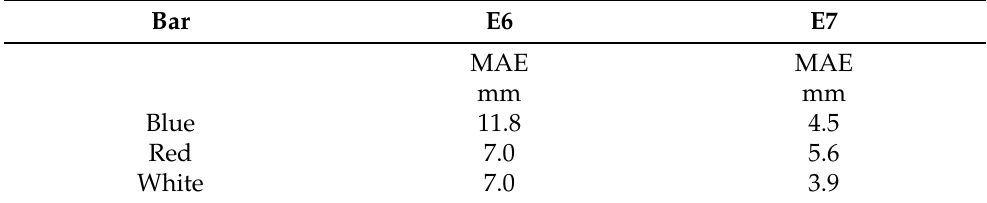
NIR T5 T6 Number of segmentation classesLuminance Red Ch. Green Ch. Blue Ch. Figure 5. Mean absolute error (MAE) in mm between unfiltered and a priori known bar lengths for all experimental tests (E6, left , and E7, right ) treated with the narrow image crop. From top to bottom , heatmaps show MAE values estimated from images of the blue ( top ), red ( middle ), and white ( bottom ) bars. In each heatmap, rows indicate MAEs obtained for different color channels: the top four rows report values for RGB images processed through four gray-scale conversion modalities (luminance, red, green, and blue channels). The bottom row refers to values for NIR images. Values are reported for all segmentation classes (T1 to T6). Table 7. MAE in mm between benchmark and filtered lengths estimated from the entire sequence of RGB and NIR images of the colored and white bars treated with the narrow